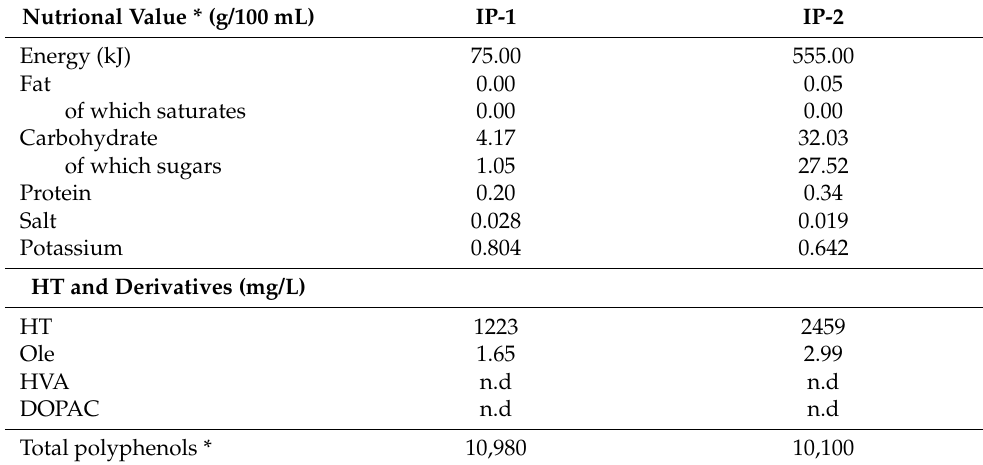
Table 1. Typical nutritional value of the food supplements, and content of hydroxytyrosol (HT) and derivatives (as free forms) in the food supplements used for the trial. Ole: oleuropein, HVA: homovanillic acid, DOPAC: 3,4-dihydroxyphenylacetic acid. n.d.: not detectable; *: according to